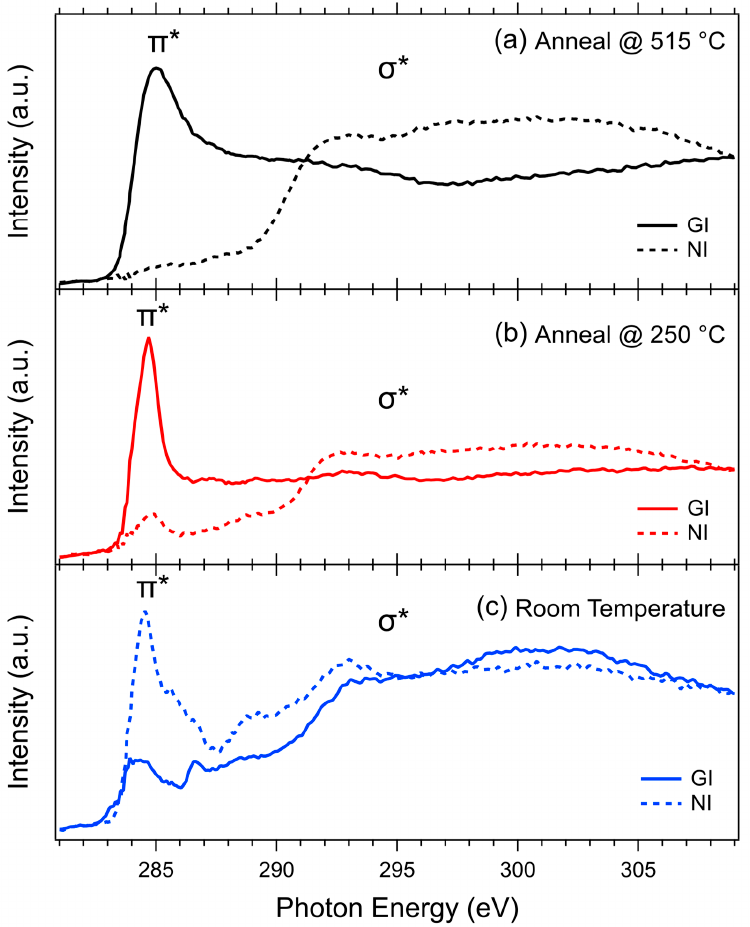
Figure 3. Polarization-dependent C K-edge NEXAFS spectra of BPBr 2 /Cu(111) after thermo treat- ment: ( a ) anneal at 515 ◦ C, ( b ) anneal at 250 ◦ C and ( c ) as deposited (RT). The π * and σ * resonances were dependent on the grazing incident (GI) and normal incident (NI) polarizations, respectively, which is the so-called “linear dichroism of